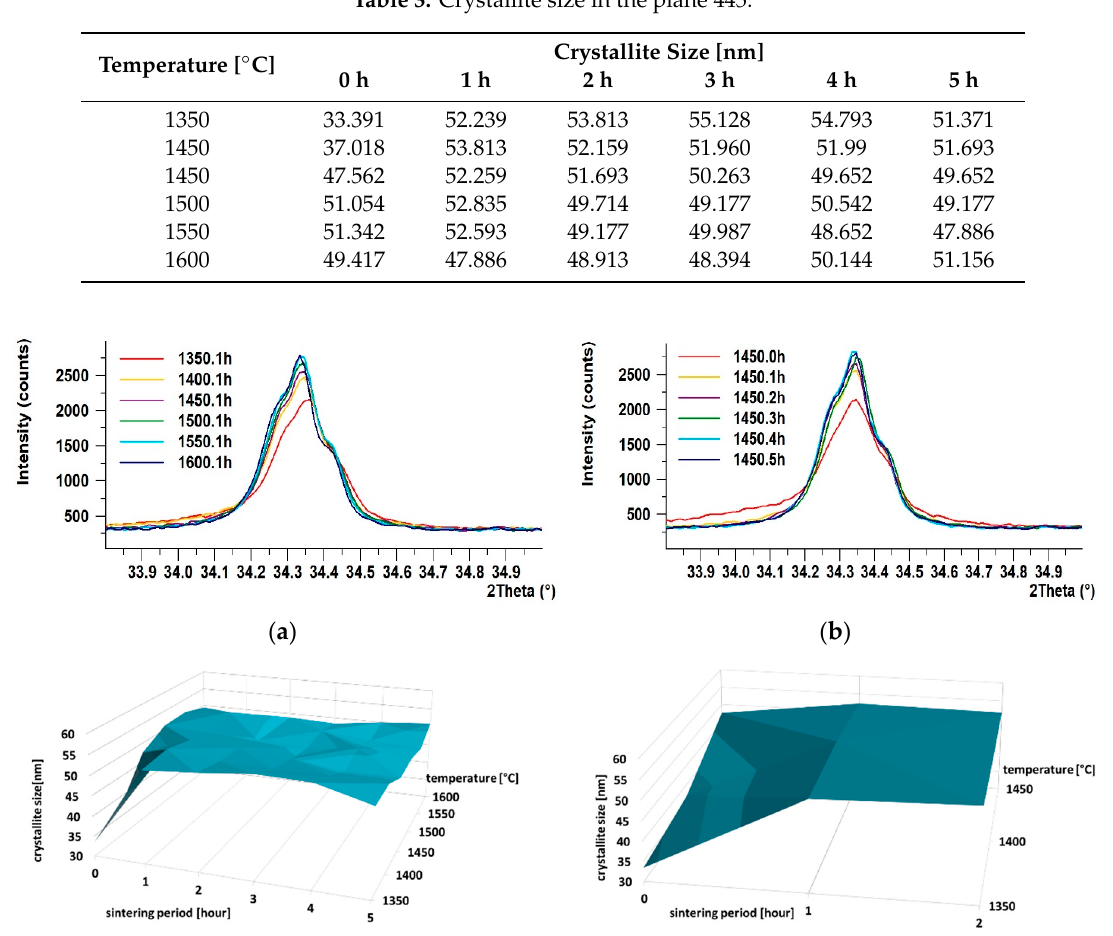
Table 3. Crystallite size in the plane 445.